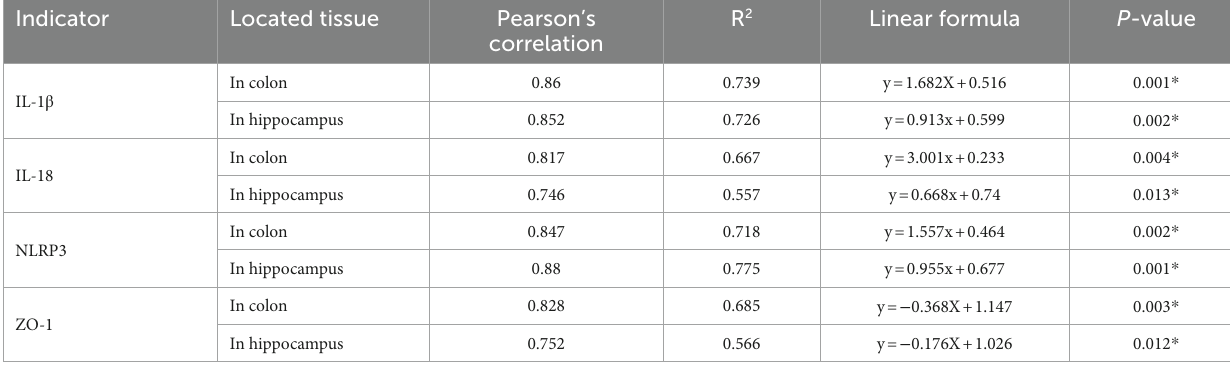
TABLE 1 Pearson’s correlation analysis between G + /G − ratio and targeted indicators.